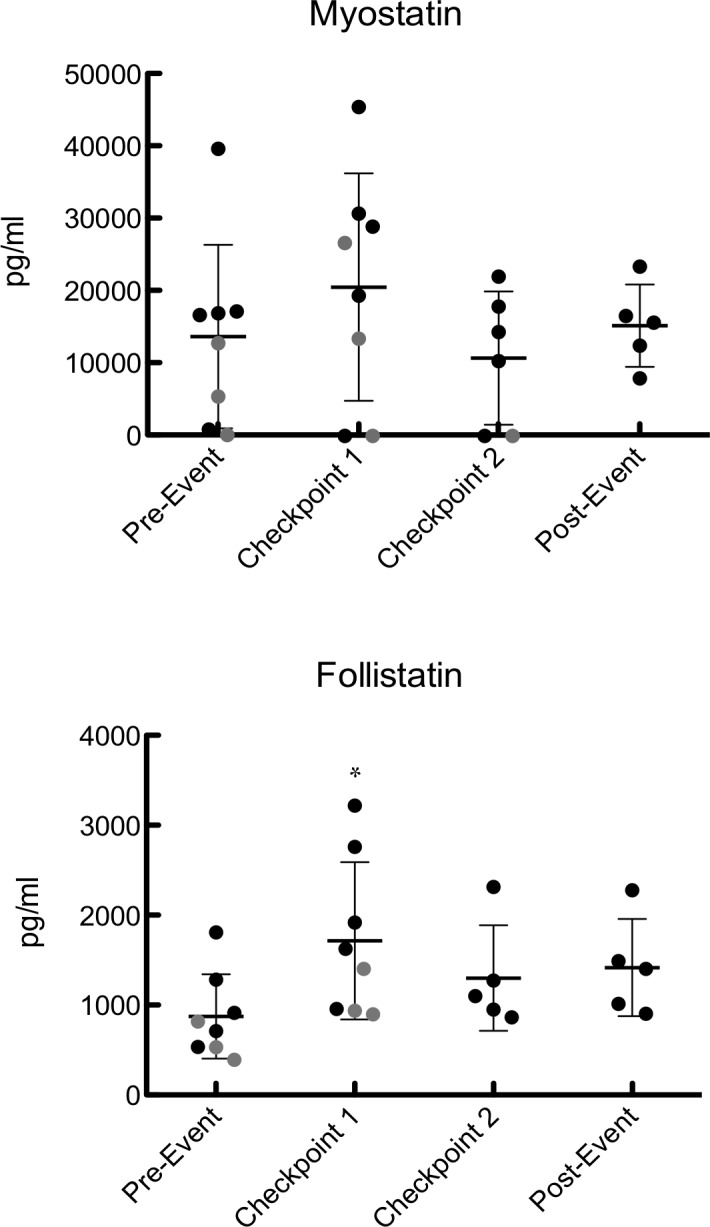
Serum follistatin and myostatin during pre-event, C1, C2, and post-event. Data points colored in black represent finishers and data points represented in gray represent dropouts. For samples below the limit of detection of the assay (270 pg/ml for myostatin), the samples were assigned a value of half the LOD to avoid biasing the results. Values are expressed as mean ± SD. *Represents significant difference from baseline.